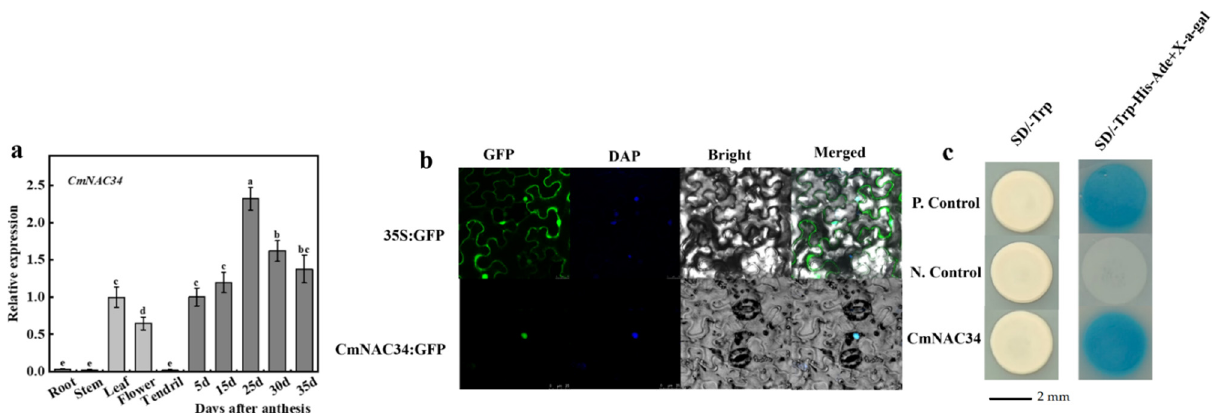
Figure 3. Expression profile and functional analysis of CmNAC34. ( a ) Temporal and spatial expres- sion profile of CmNAC34 in ‘HDB’. Values represent the mean ± SE of three replicates. Different letters represent a statistically significant difference ( p < 0.05). ( b ) Subcellular localization of CmNAC34, GFP is green fluorescent protein (green); DAPI is nucleus dye (blue); bright filed, white light; merged is the combination of GFP signal with DAPI (cyan). ( c ) Transcription activity of CmNAC34 in the yeast system. CmNAC34 was inserted into the pGBKT7 vector and transformed into yeast cell Y2H Gold. The yeast cell was cultured in amino acid-deficient medium SD/-Trp or SD/-Trp-His-Ade with X- α -gal. P. Control, positive control (pGBKT7-53 + pGADT7-RecT), N.Control, negative control (empty pGBKT7 vector), CmNAC34, pGBKT7-CmNAC34 vector.